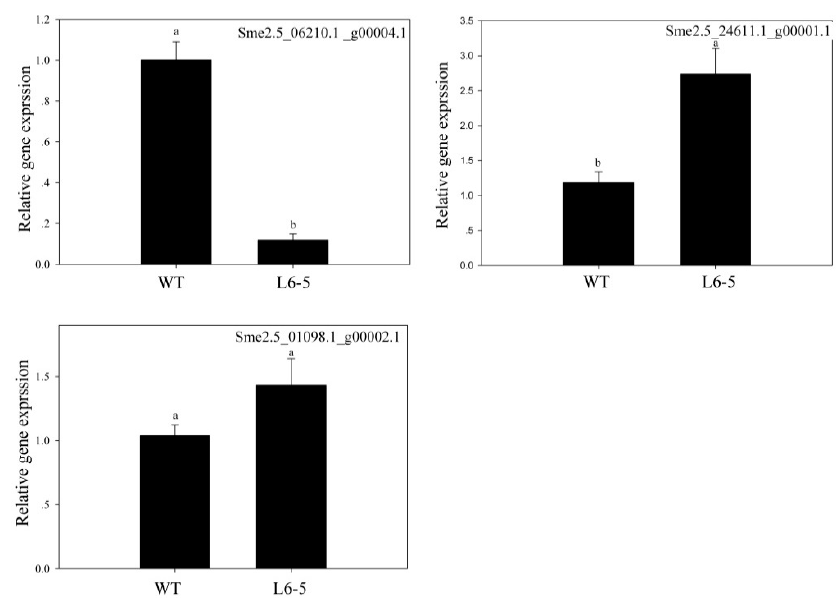
Figure 5. Biosynthesis of other secondary metabolites KEGG of the high-impact mutations gene in the four EMS-induced eggplant mutants. The high-impact mutations gene include the nonsense mutations and frameshift mutations genes. 48-5 and L6-5 were white fruit mutants.